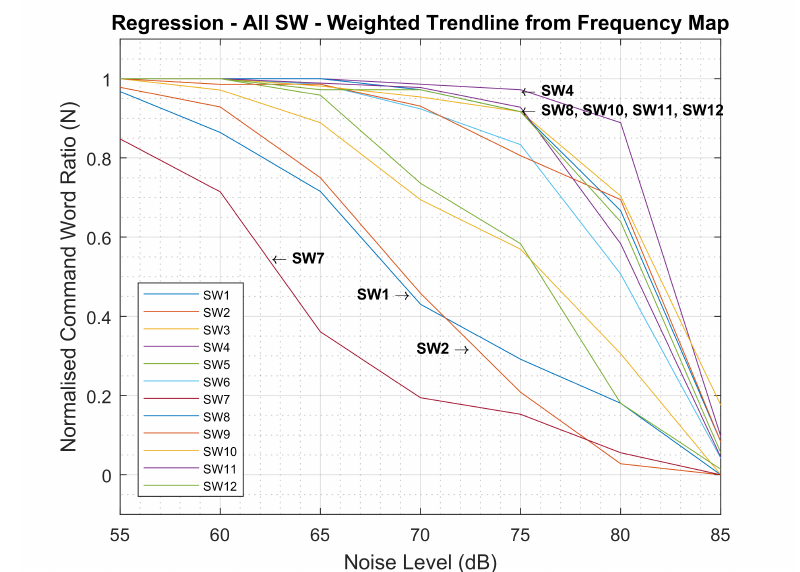
Figure 12. Comparing all SW